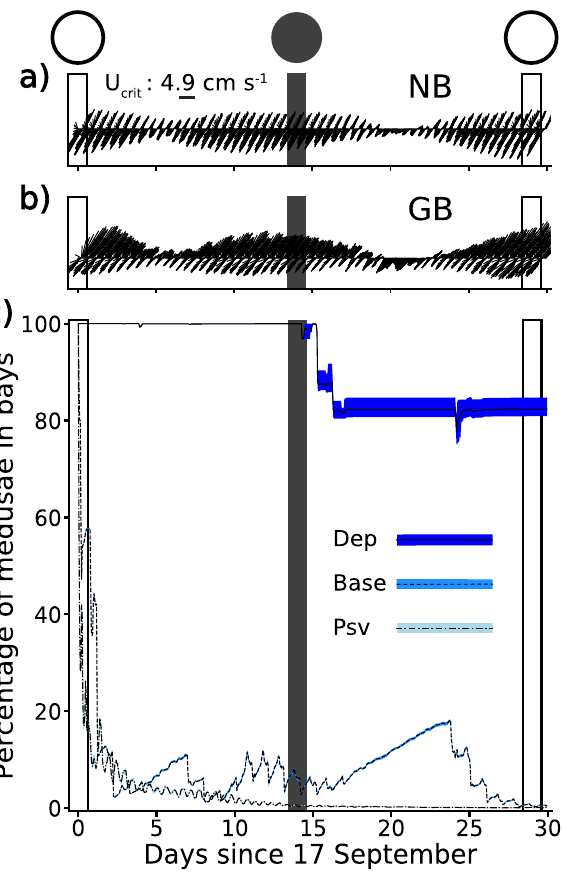
Figure 2. Role of behaviour in retention main analysis (blue colour scale). The simulated currents experienced by medusae (i.e., half the depth averaged current) at sites in ( a ) Nelly Bay (NB) and ( b ) Geoffrey Bay (GB), as marked in Fig. 1. The lengths of the sticks indicate the speed and the sticks are oriented in the direction the current flowed to. The reference stick shows the stick length for a speed of U crit . ( c ) The average percentage of Copula sivickisi medusae remaining in NB and GB through time as simulated with the passive (Psv), base (Base) and dependent (Dep) models. The bands underlying each line indicate the range of percentages simulated among the five replicate model runs. The circles at the top of the figure, and the vertical lines running down from them, show when there was a full (white) or new (grey)